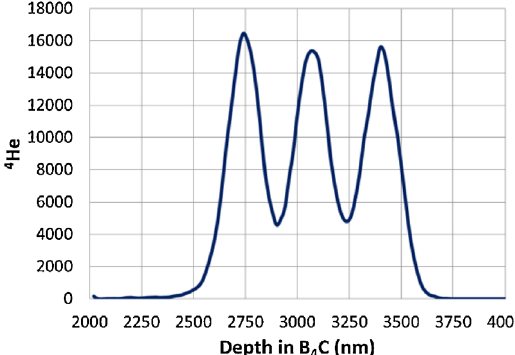
Fig. 6. Helium implantation in B 4 C given by SRIM [19]: 4 He, 2.8 – 2.9 – 3.0 MeV, 1.5 (cid:1) 10 16 at/cm 2 with a 6 m m thick aluminium foil placed in front of